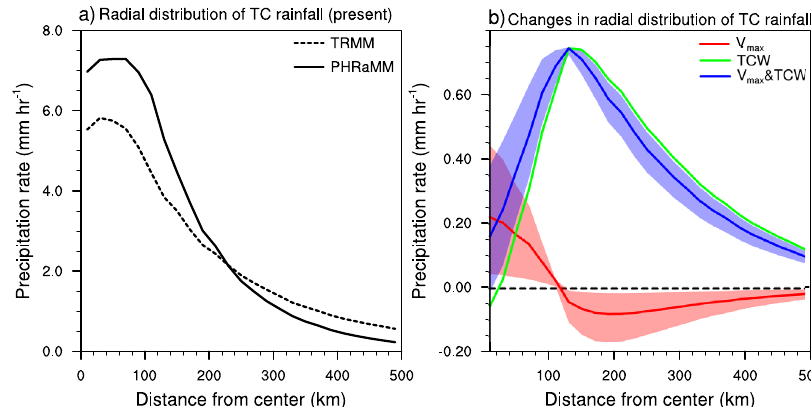
Fig. 1 Mean radial distribution of tropical cyclone (TC) rainfall in the present and future climate. a The TRMM (dashed line) and PHRaMM (solid line) for the present climate. b Future changes compared to the present climate according to the increases in the maximum wind speed ( V max ) by 1 – 10% (red line and shading), increase in the total column water (TCW) by 14% (green line), and increase in both (blue line and shading). The red and blue lines indicate the results according to the median value of V max increases ( + 5%), and shadings present the ranges of change based on the ranges of V max increases ( + 1 –